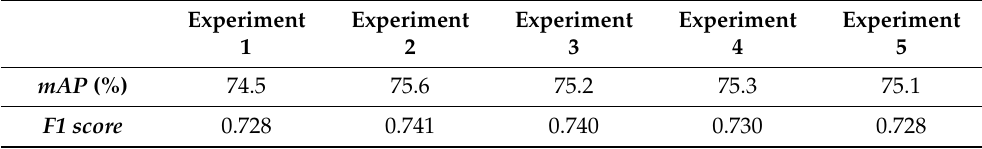
Table 8. Results of YOLOv5s on TT100K dataset.